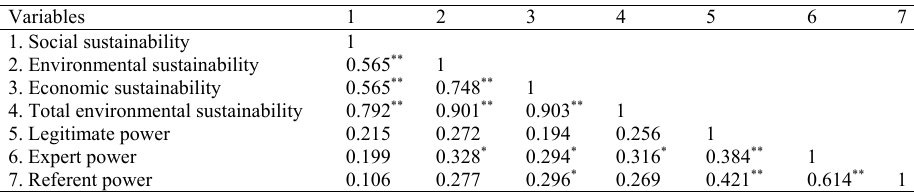
Table 5: Correlation analyses of environmental sustainability and sources of leader power Variables